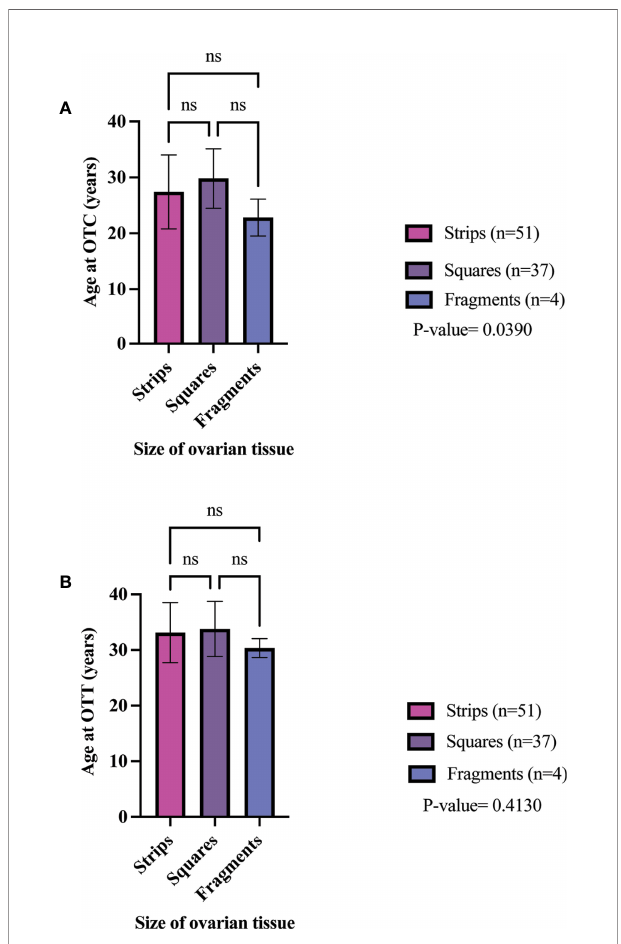
FIGURE 3 | Age of participant at OTC (A) and OTT (B) in different size cryopreserved and transplanted ovarian tissue. P-values greater than 0.05 were considered not signi fi cantly different (ns) (21, 22, 25, 34, 37, 44, 57, 59, 61, 64, 66, 78, 84, 91 – 93, 95, 111, 115, 118,